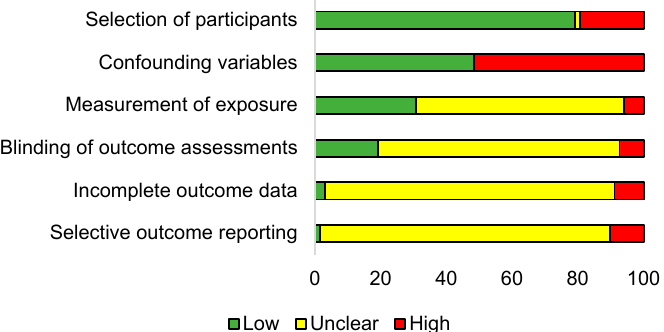
Figure 2. Percentage for each risk-of-bias domain regarding the included trials.